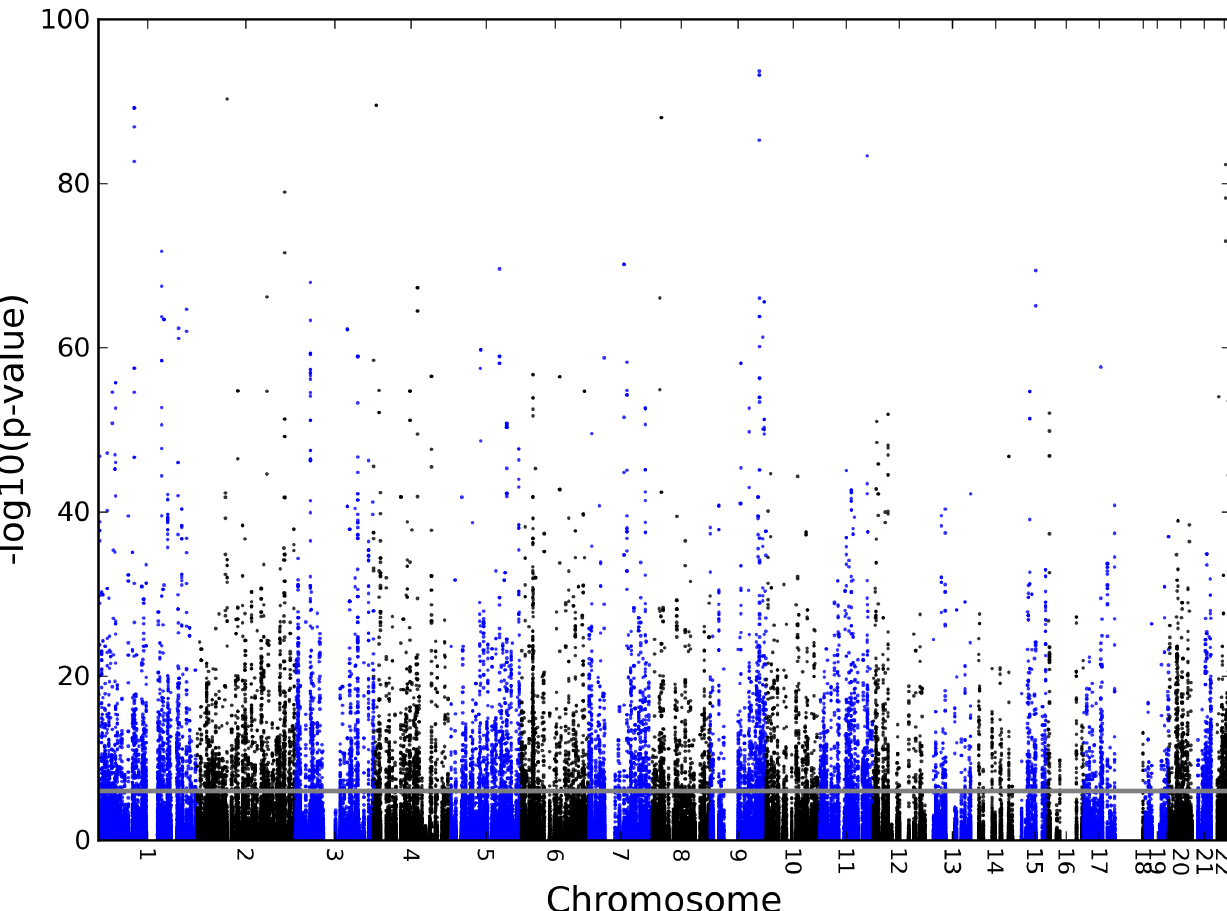
Figure 2. Manhattan plot. Manhattan plot with the p-values from ASE association tests between SNPs and lncRNAs on the vertical axis and the genomic lncRNA regions analysed in the study on the horizontal axis. The p-value cut-off of 10 2 6 is shown as a grey line.